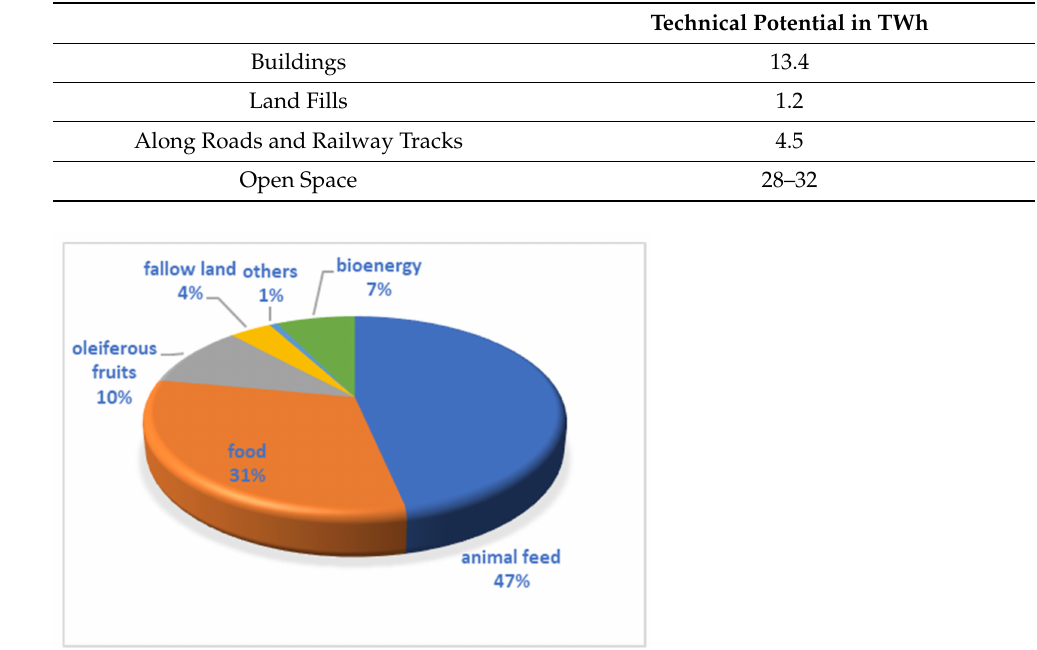
Table 1. Potential of PV in Austria.